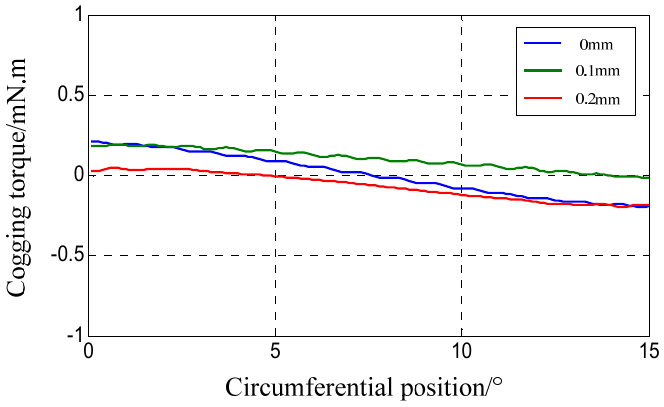
Figure 17. Comparison of cogging torque with skew in a variable period.